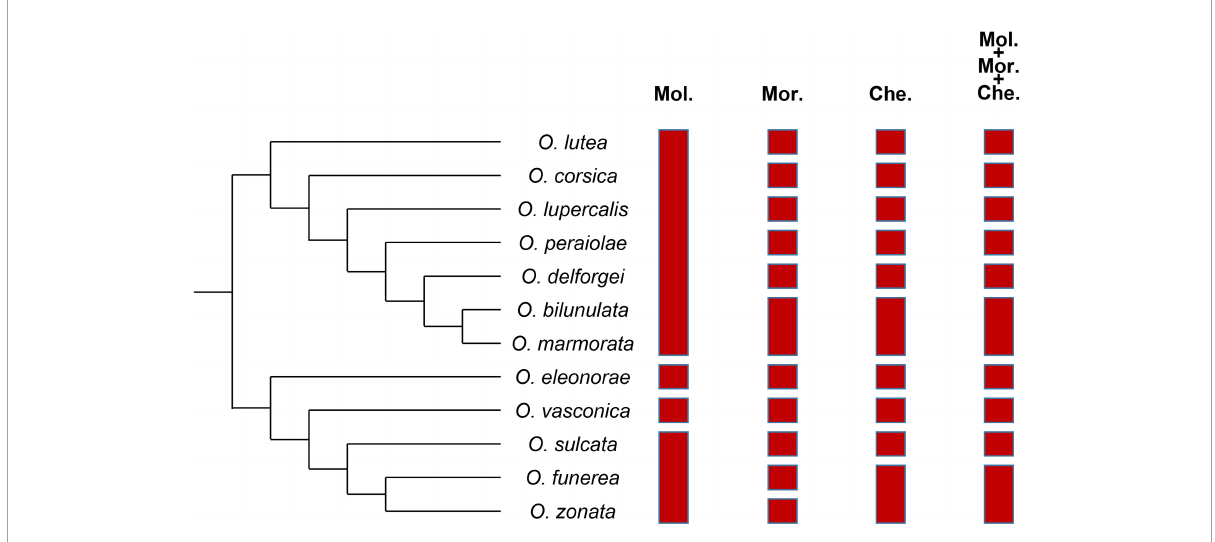
FIGURE5 Results from the iBPP analysis based on molecular (Mol.), morphometric (Mor.), and chemical (Che.) data analyzed alone or in